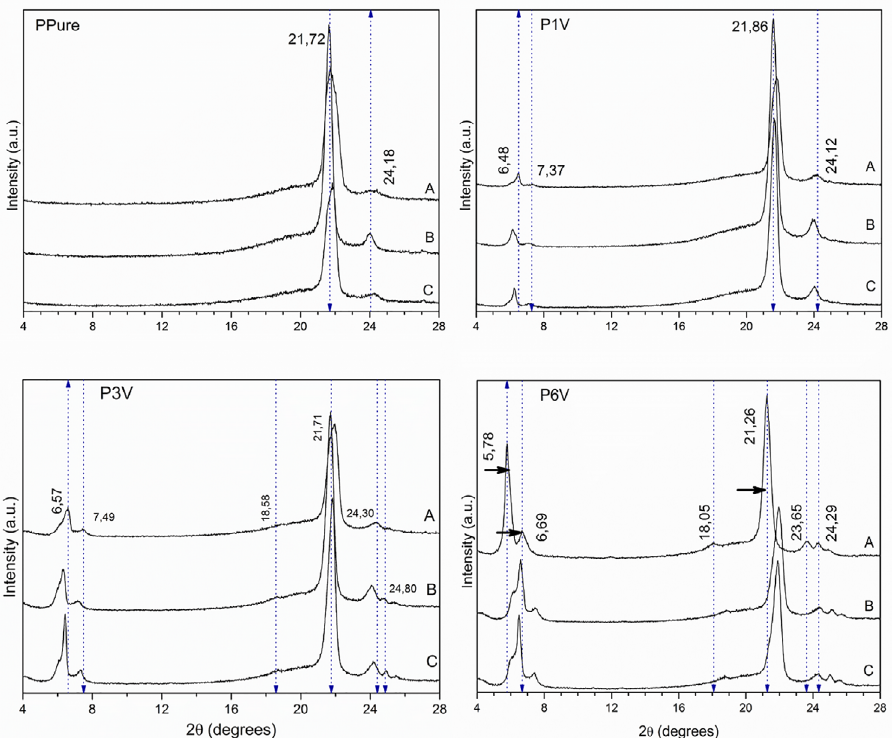
in the time of 10 min 1